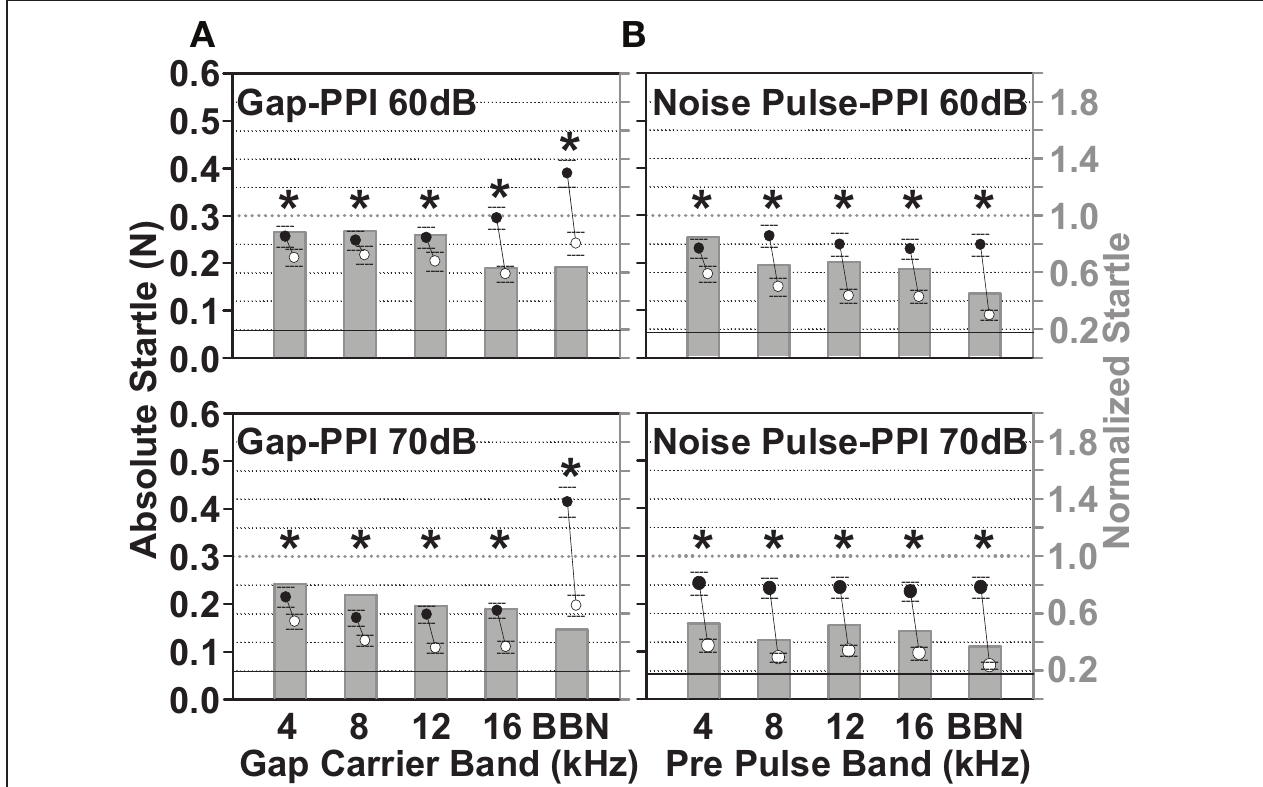
FIGURE 6 | Guinea pigs show significant detection of gaps in background noise and noise pulses of 60 and 70dB SPL. Baseline gap-PPI (A) and noise pulse-PPI (B) are shown before noise exposure for five different noise bands of the gap-carrier and noise pulse: 4–6kHz, 8–10kHz, 12–14kHz, 16–18kHz, and BBN. Top panels show the PPI of a 15ms gap embedded in a 60dB SPL gap-carrier and of a 15ms pre pulse of 60dB SPL, lower panels show the respective data for 70dB SPL gap-carrier and noise pulse. The data is from 14 animals, during the three or four test-days per animal directly before the noise exposure (two days per week, Monday and Thursday), for 10 repetitions per stimulus condition. Normalized